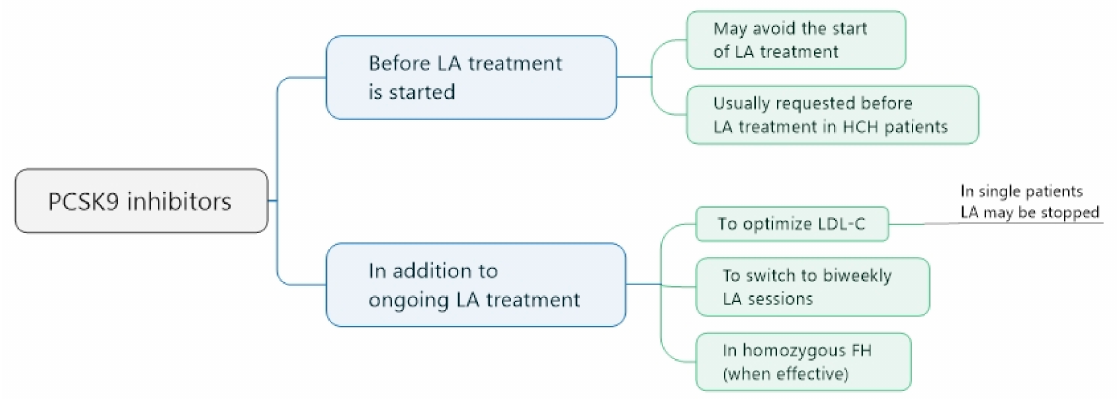
Figure 4. PCSK9 inhibitors and LA in HCH